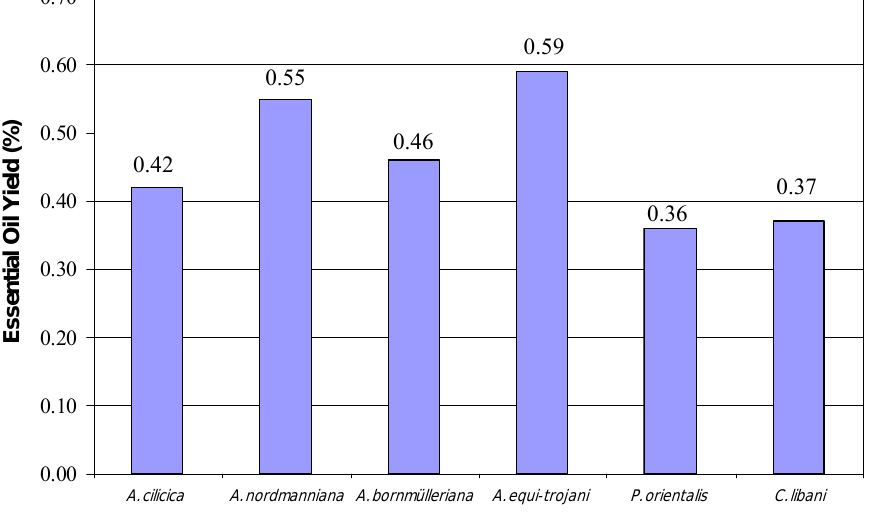
Figure 2. Essential Oil Yields of Fir Spruce and Cedar species from Turkey